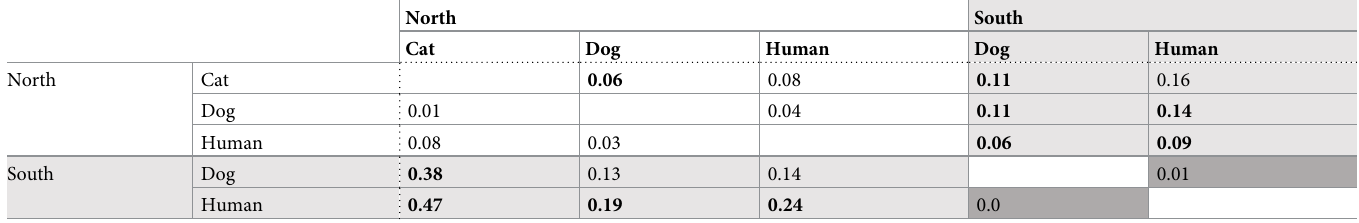
origin (Tables 4 and 5). Mean pairwise F among hosts within regions was 0.03 ( ± 0.03), 0.02 ST ( ± 0.004), and 0.05 ( ± 0.02) for mitochondrial haplotypes, derived maternal microsatellite genotypes, and pseudo-dominant microsatellite phenotypes, respectively. The only significant intra-region, inter-specific differentiation was that of northern dog versus northern cat hosts for both iterations of the microsatellite genotype ( F 0.02 and 0.06, p = 0.04 and < 0.001, ST respectively). Mean pairwise F among regions were higher (0.26 ± 0.13; 0.06 ± 0.02; and ST 0.11 ± 0.03 for mitochondrial haplotypes, derived microsatellite genotypes, and pseudo-domi- nant microsatellite phenotypes, respectively) and almost all significant at p < 0.05 (Tables 4 and 5). Table 4. Pairwise F ST among mitochondrial haplotypes and pseudo-dominant microsatellite phenotypes in Chadian D . medinensis